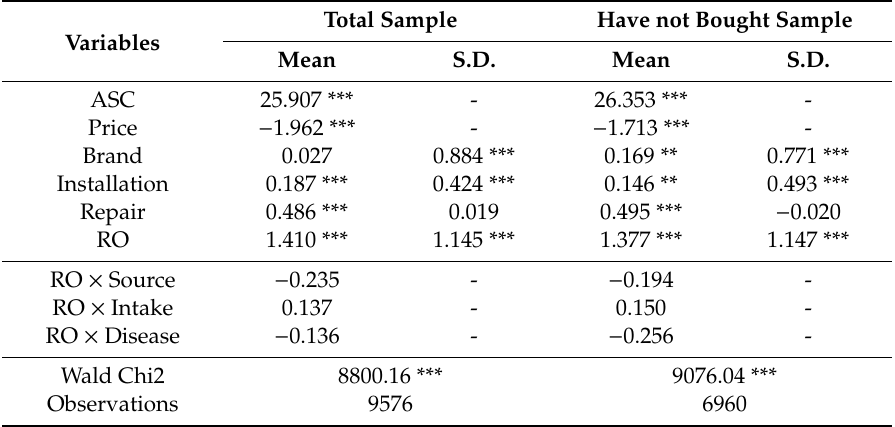
Table 6. The results of scientific knowledge e ff ects on the defensive attribute